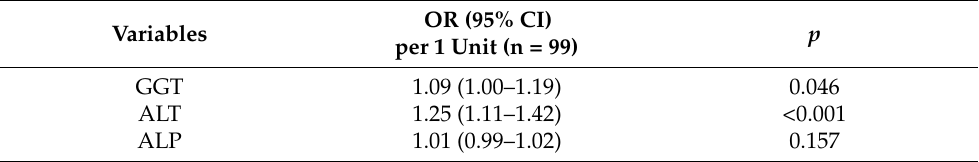
Table 3. Multivariable regression analysis for MetS prediction by fasting levels of liver enzymes.